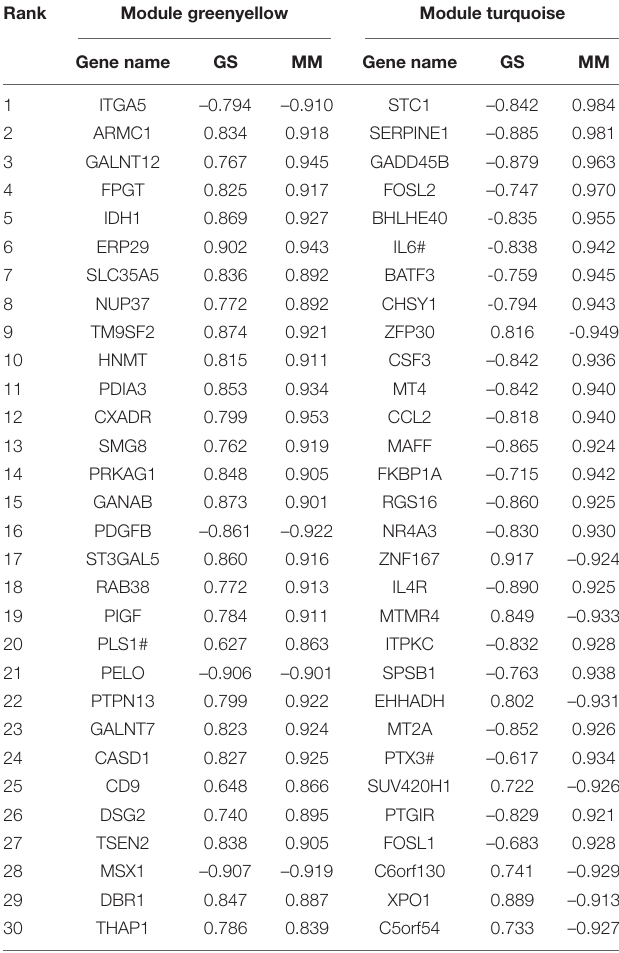
TABLE 1 | Top 30 Hub Genes in the light green and turquoise module of GSE81292. Rank Module greenyellow Module